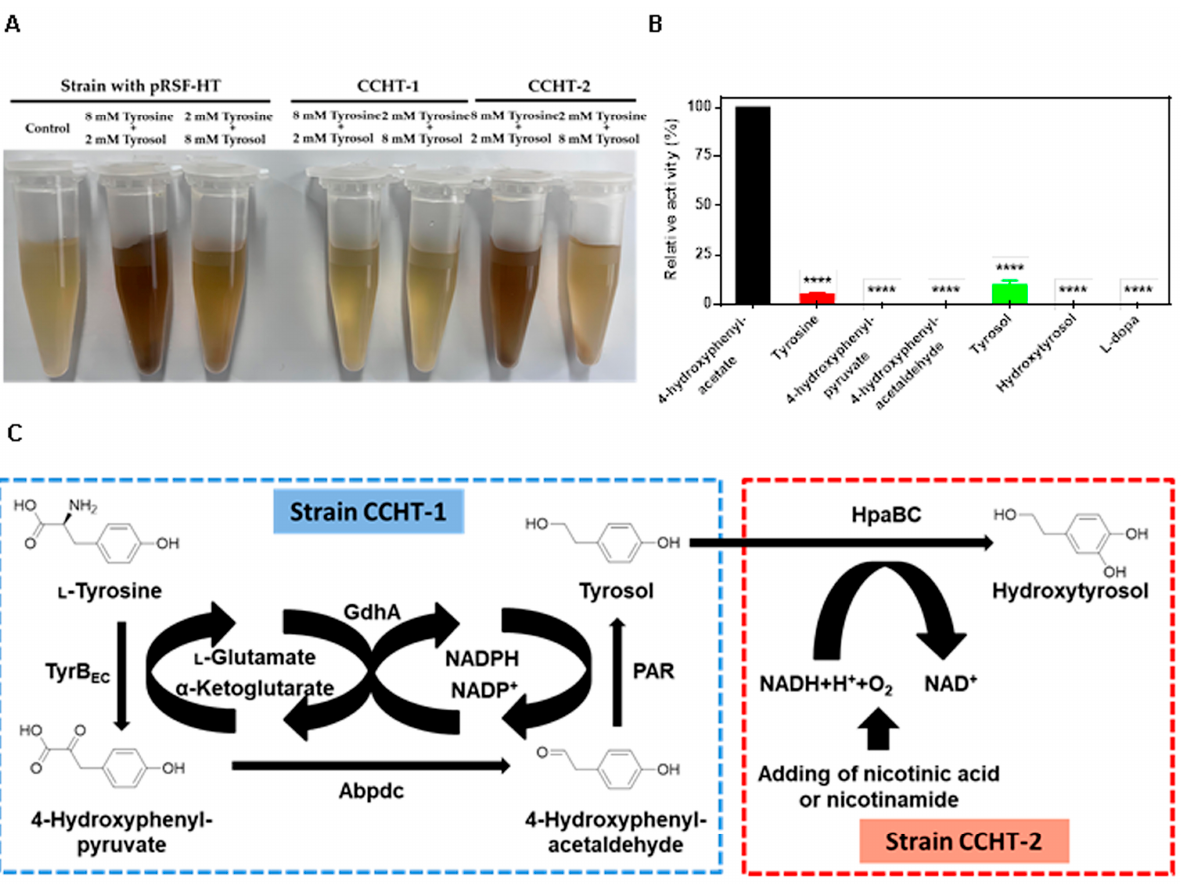
Figure 3. The promiscuity of HpaBC and design of a microbial consortia catalysis strategy. ( A ) The color change of strain with pRSF-HT plasmid, CCHT-1, and CCHT-2 cultured with total 10 mM substrate (tyrosin and tyrosol). ( B ) Catalytic activities of HpaBC towards different substrates. ( C ) Design of a microbial consortia catalysis strategy by dividing the biosynthetic pathway into two individual strains. Data are expressed as the mean ± SD ( n = 3). **** p < 0.0001, compared to the control.